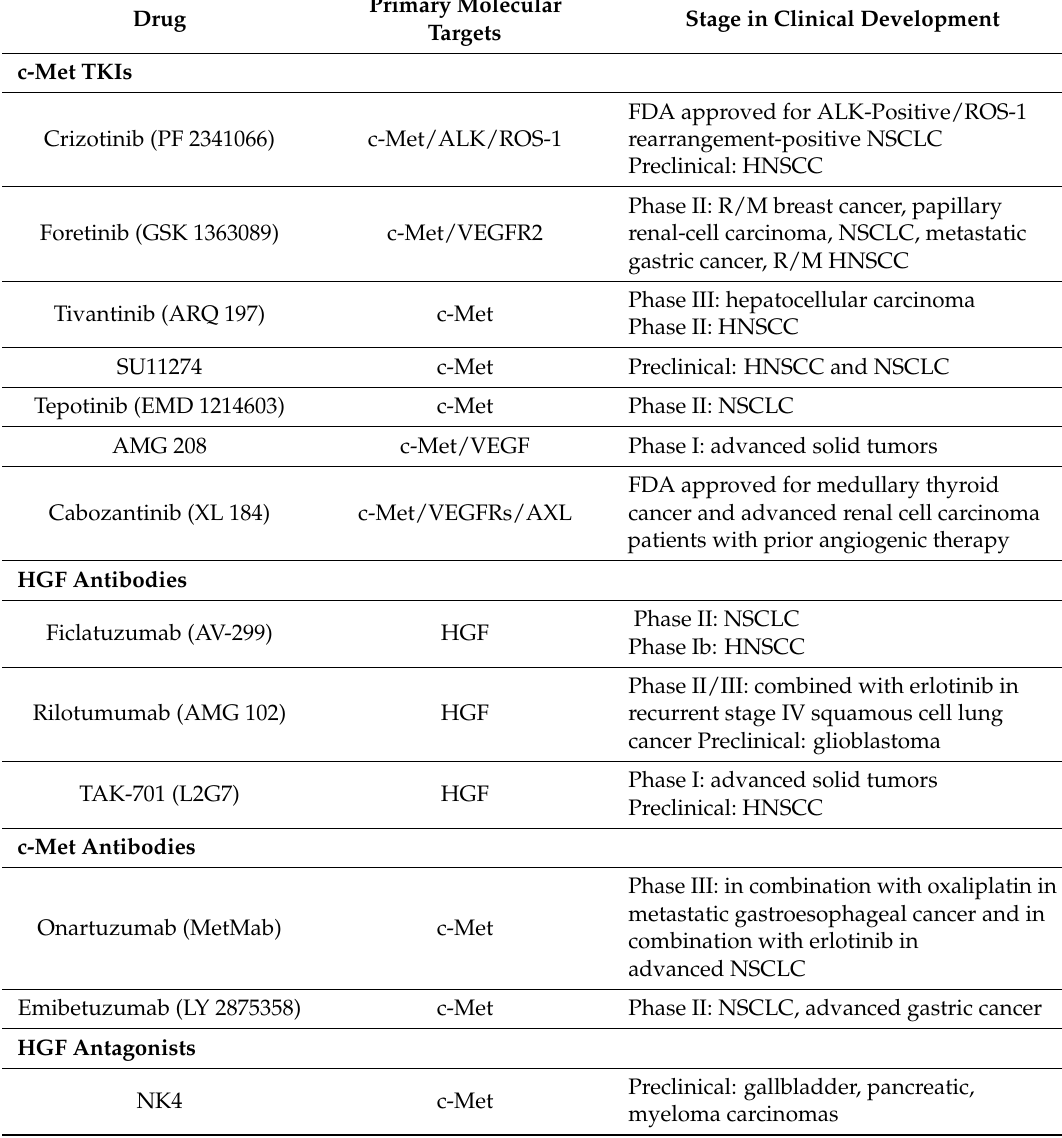
Table 3. Drugs Targeting the HGF/c-Met